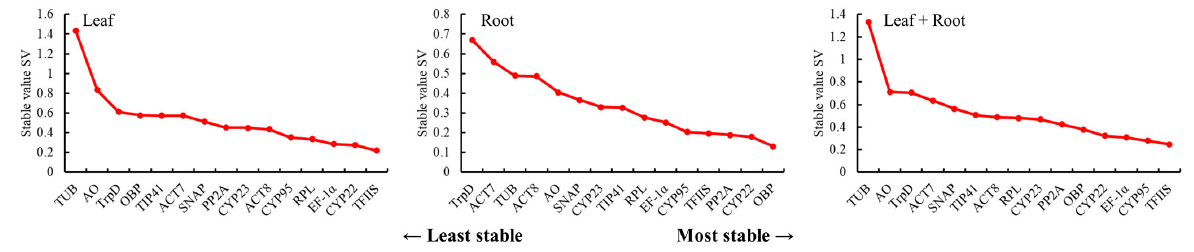
Figure 6. Expression stability values for 15 candidate reference genes calculated by NormFinder.